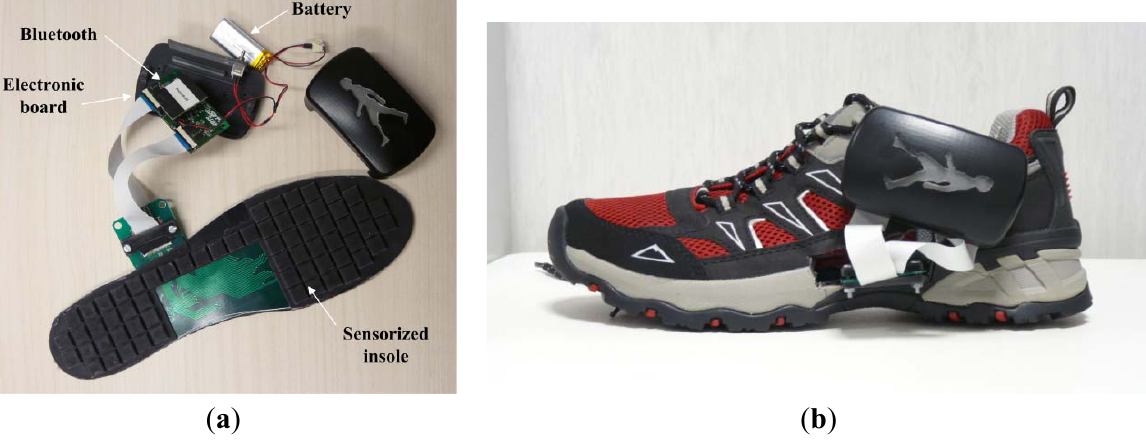
Figure 14. PSP2.0-based pressure-sensitive insoles. ( a ) Overview of the pressure-sensitive insole on the bench; ( b ) two pressure-sensitive insoles integrated into normal sneaker